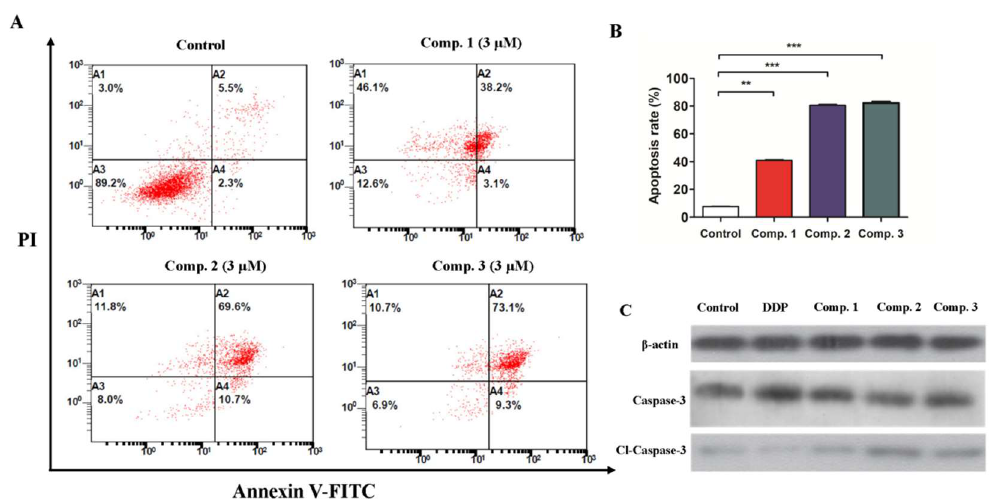
Figure 7. Compounds 1-3 induced A549 cell apoptosis. ( A ) The representational pictures of flow cytometry in cell apoptosis with or without indicated compound 3 μM for 24 h. ( B ) Apoptosis rates of compounds 1-3 as well as control group. ( C ) The expression of apoptosis related proteins after the treatment of compound 1-3 for 24 h by Western blot assay. Data are expressed as means of the percentages of apoptotic cells from three independent experiments. ** p < 0.01, *** p < 0.001 vs. control group.